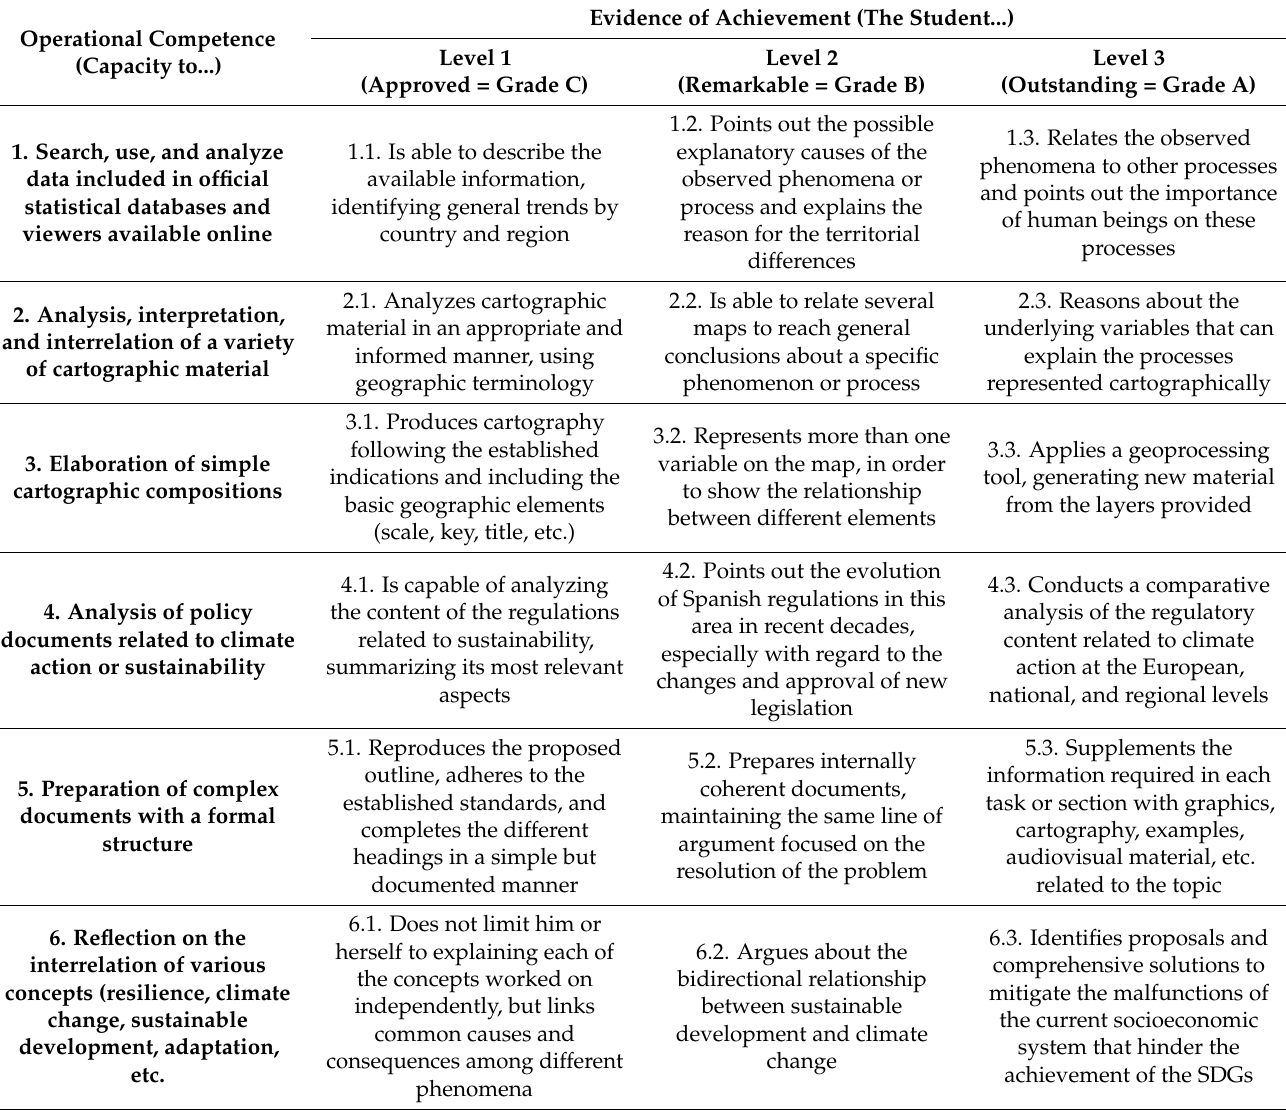
Table 2. Operational competences and evidence of